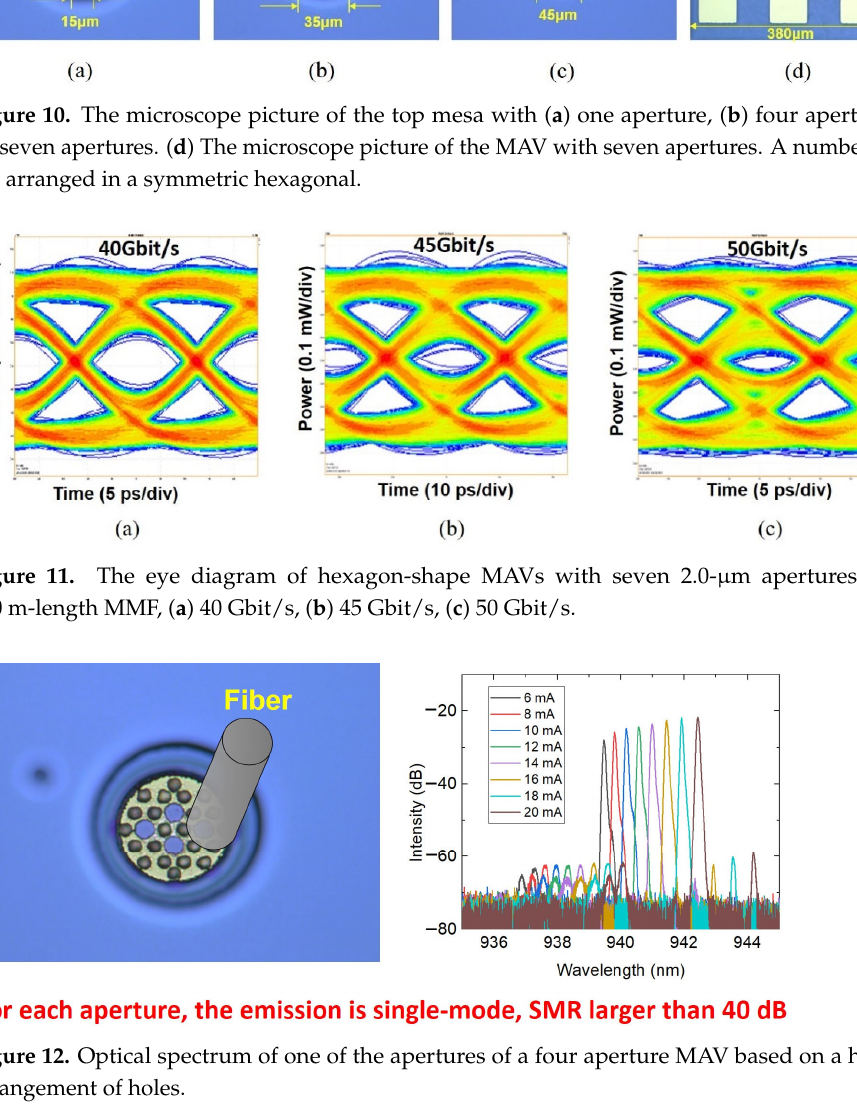
Figure 12. Optical spectrum of one of the apertures of a four aperture MAV based on a hexagonal arrangement of holes.